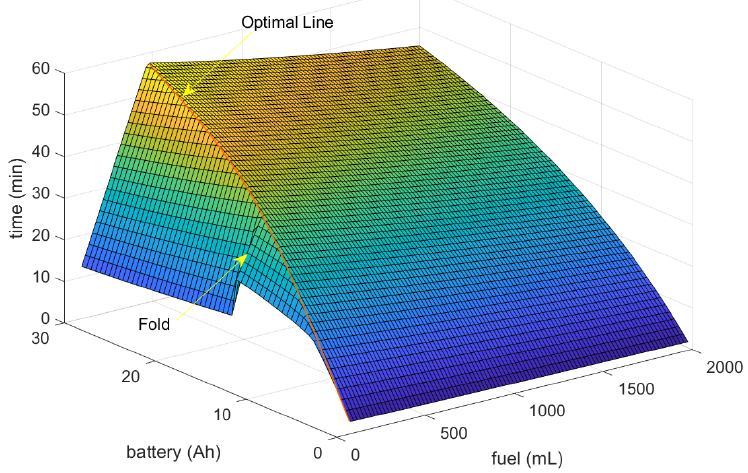
Figure 18. Flight times for 50:50 gas-to-electric ratio.